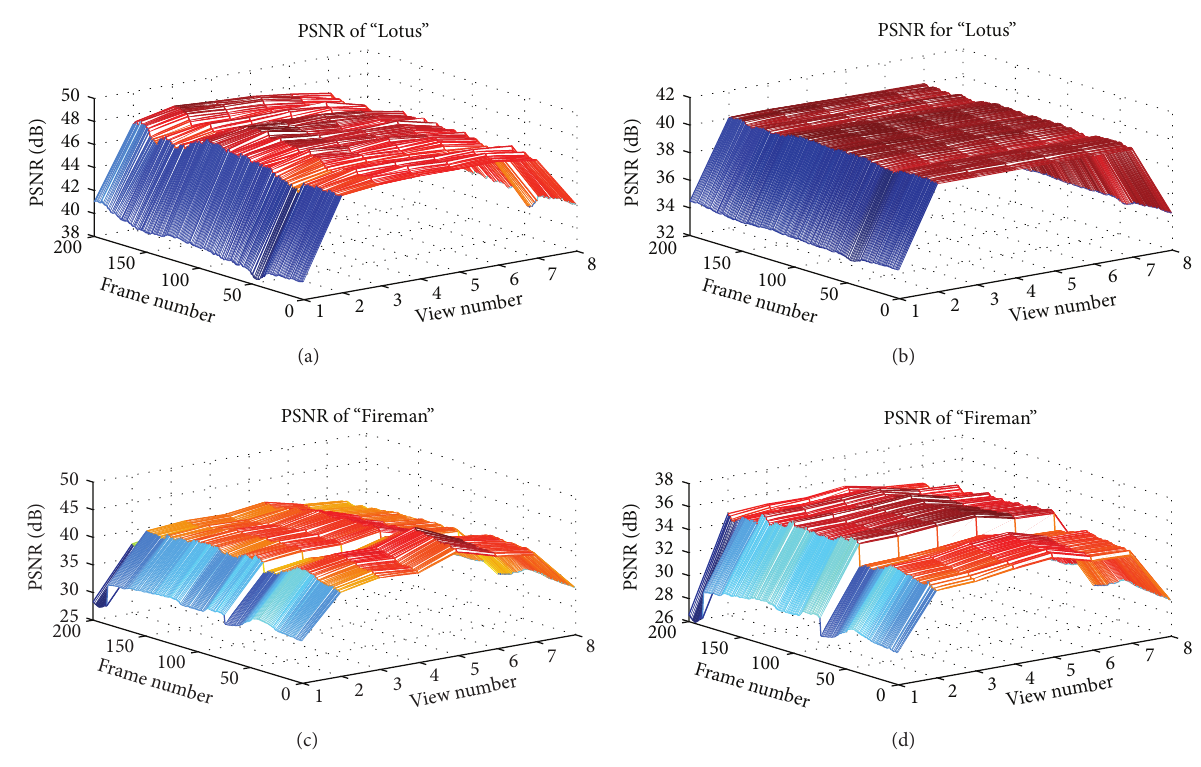
Figure 5: PSNR versus both the frame and the view numbers in corrected sequences. (a) PSNR of corrected “Lotus” by our method. (b) PSNR of corrected “Lotus” by the method in [11]. (c) PSNR of corrected “Fireman” by our method. (d) PSNR of corrected “Fireman” by the method in [11].